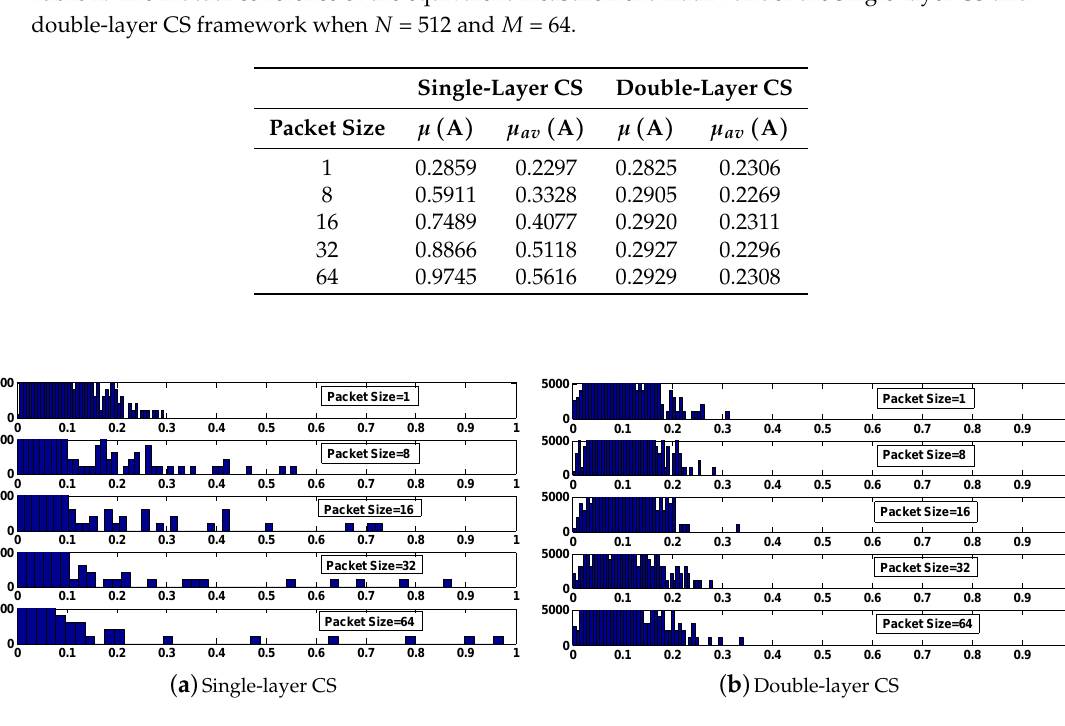
Figure 7. Histograms of the absolute off-diagonal elements of the corresponding Gram matrix to the equivalent measurement matrices under the single-layer CS and double-layer CS framework when N = 512 and M =